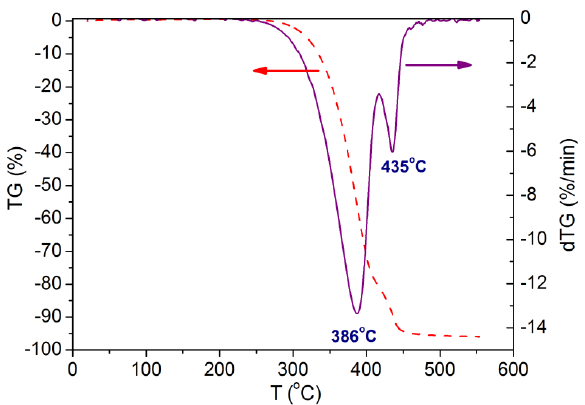
Figure 9. Thermogravimetric (TG) and differential (dTG) curves of 10-BPhCOOH in Ar atmosphere.